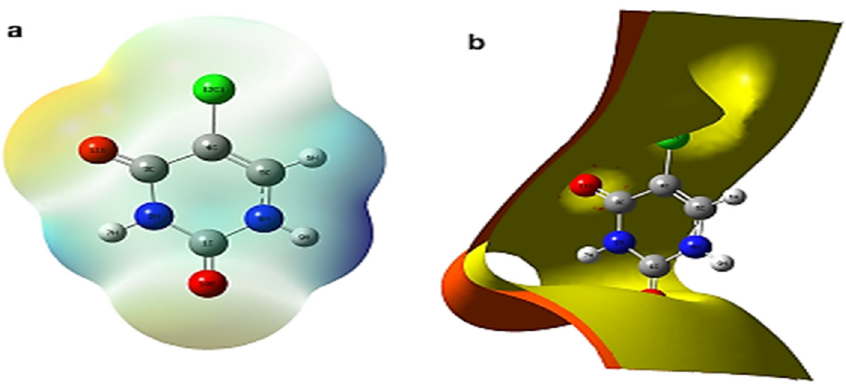
Figure 11. ( a ) The surface plots of MEP and ( b ) the iso-surface contours electron density EPS mapping of 5-chlorouracil. Reproduced with permission from ref. [83]; Copyright 2022, Springer. On surface mapping/arrays, MEP increases in the following order: red, orange, yellow, green, and blue. In this case, negative MEP reflects the attraction of a proton in the red region owing to the concentrated ED in the molecule, whereas positive MEP indicates the repulsion of a proton in the blue zone due to the atomic nuclei regions and the low concentration of ED in the molecule. The red hue represents the negative area and suggests nucleophilic reactivity, whereas the blue color depicts electrophilic reactivity in the positive region of MEP surface plots.